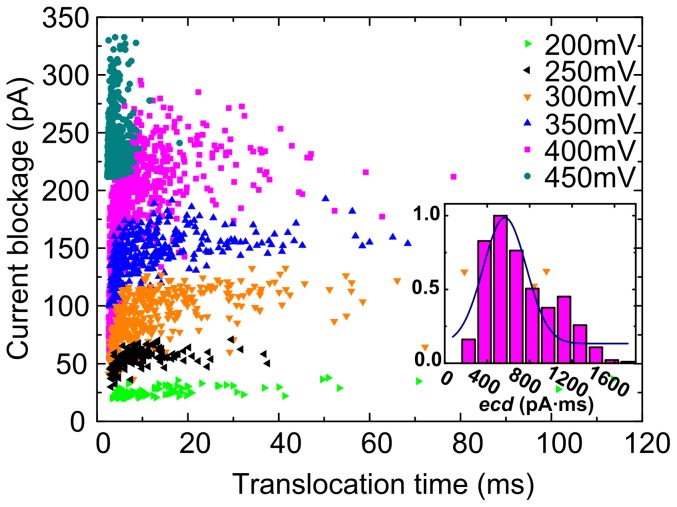
Event scatter plot of current blockage vs translocation time of λ-DNA translocation events as a function of voltage.A typical normalized histogram of 400 mV is inserted on the bottom-right. The experiments were all performed in 1 M KCl solution with 10 mM TrisHCl and 1 mM EDTA at pH of 8.0.